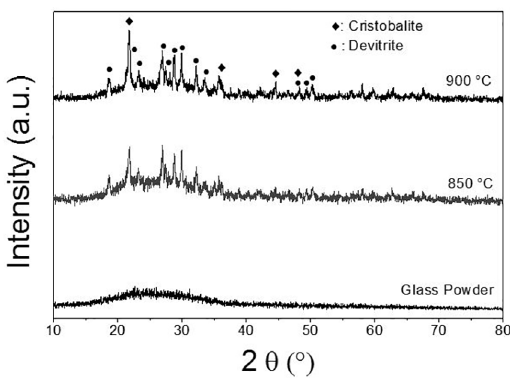
Figure 4. XRD patterns of the amorphous structure of the glass powder (as prepared) and crystalline structure of the vitrocrystalline foams containing 70 vol.% of PS spheres, fired at different temperatures (850 and 900 ºC) for 30 min. ♦: Cristobalite; ●: devitrite.